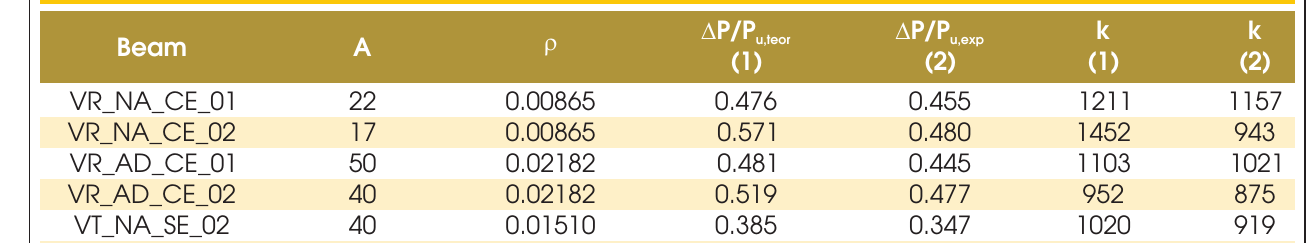
Table 5 – Constant k: experimental values